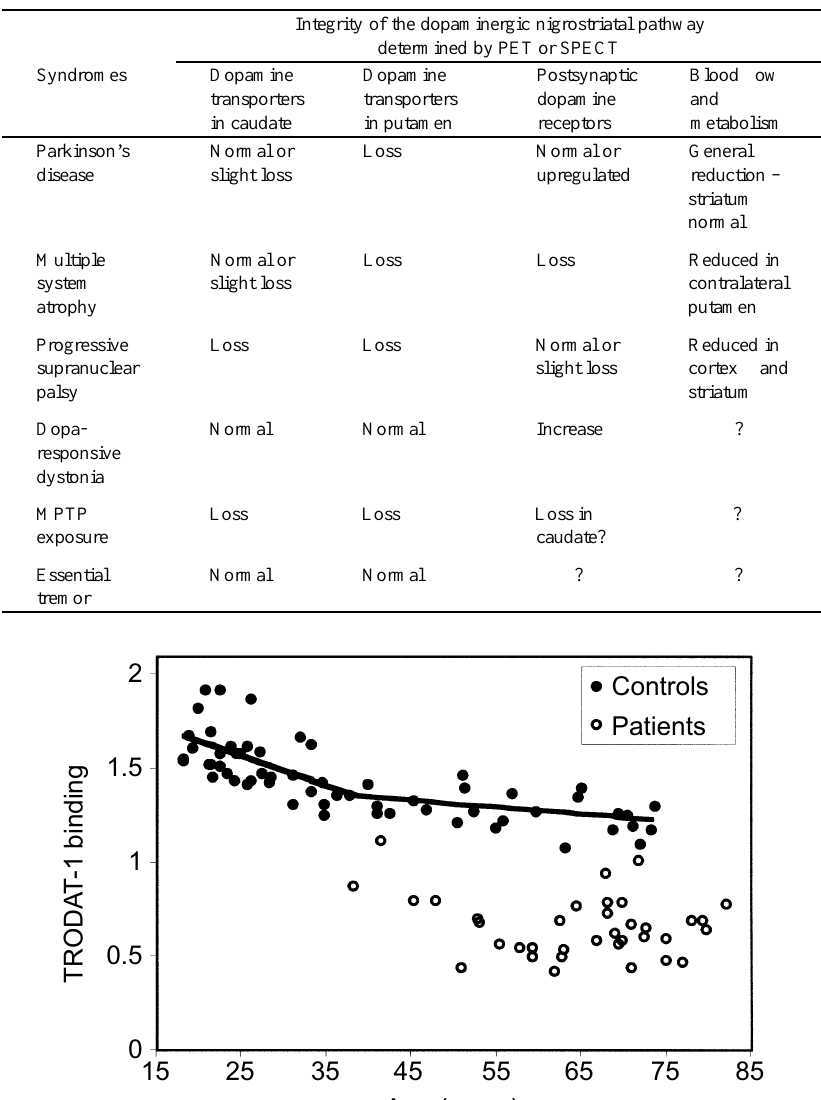
Table 2 Summary of PET and SPECT measurements of neurodegenerative and parkinsonian disorders